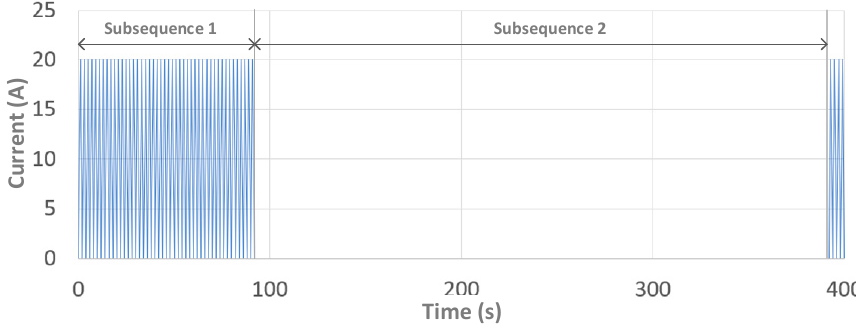
Figure 12. Graphical interpretation of the proposed regeneration sequence for deeply discharged cells.